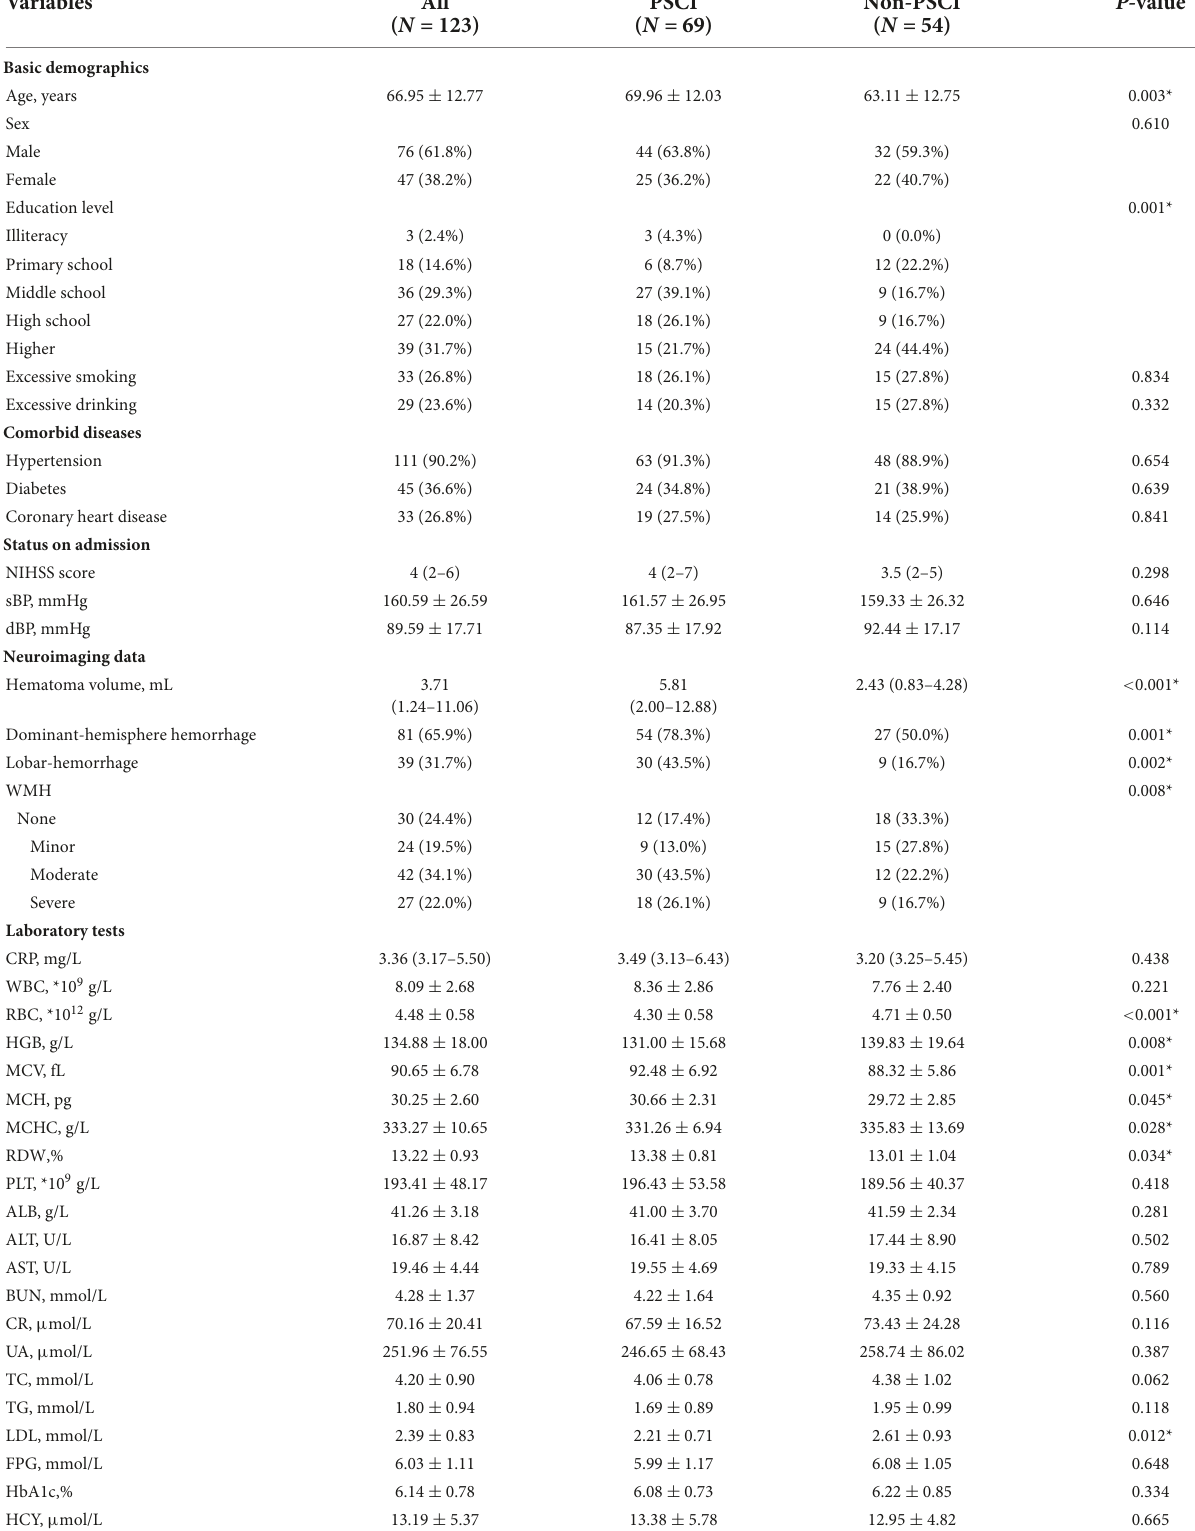
TABLE 1 Characteristics comparison of PSCI and Non-PSCI groups in ICH